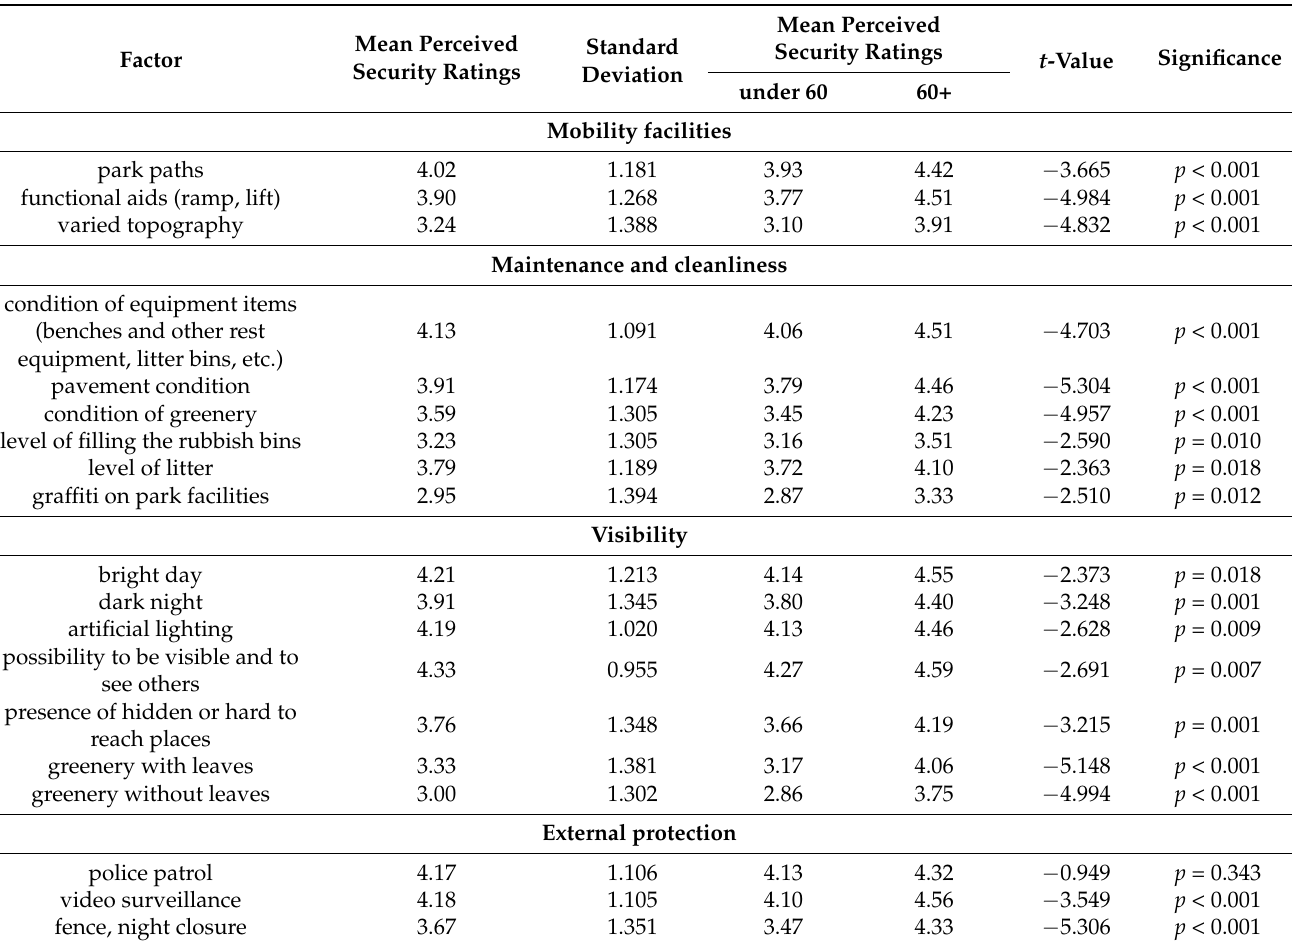
Table 3. Differences in responses between under 60 and 60+ aged park users (elaborated by